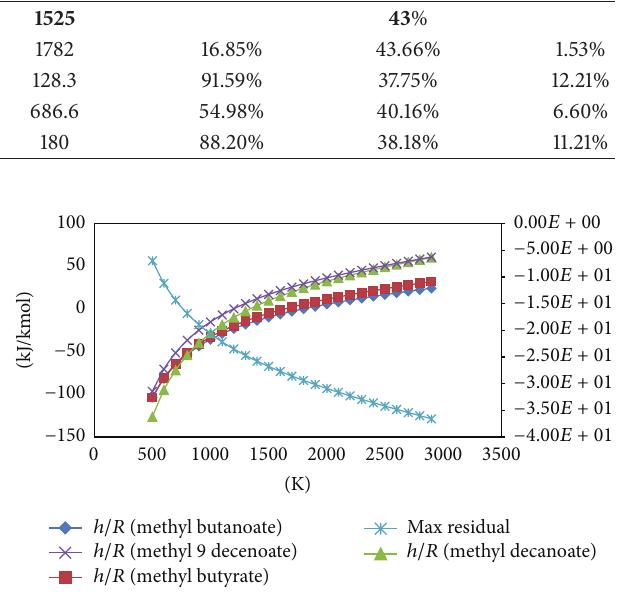
Figure 1: Variation of enthalpy against temperature for biodiesel